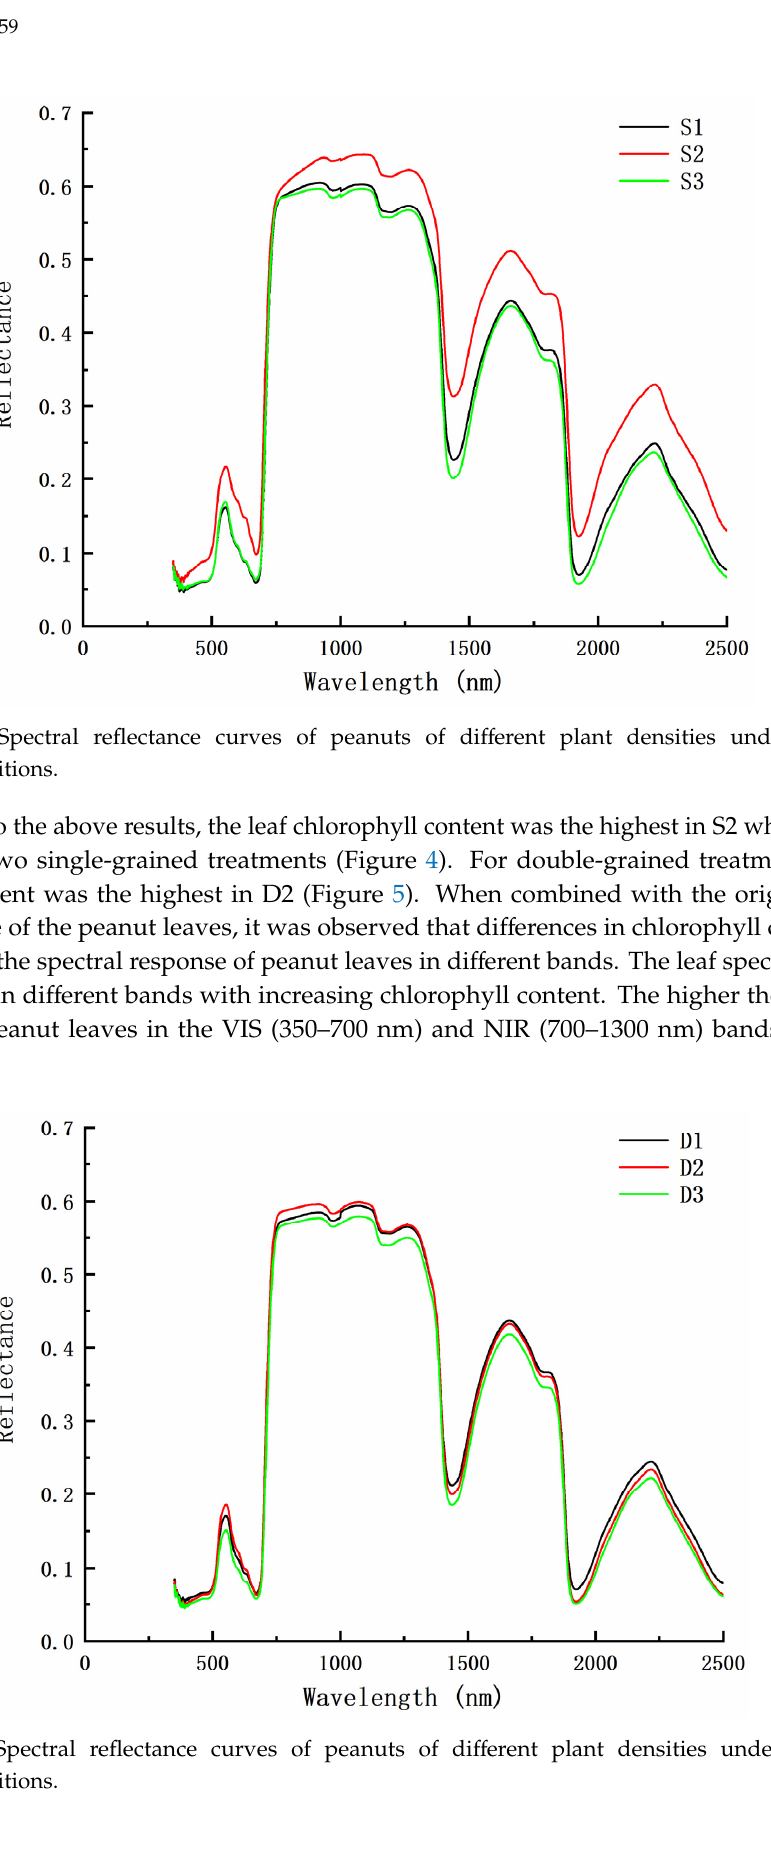
Figure 5. Spectral reflectance curves of peanuts of di ff erent plant densities under double seeding